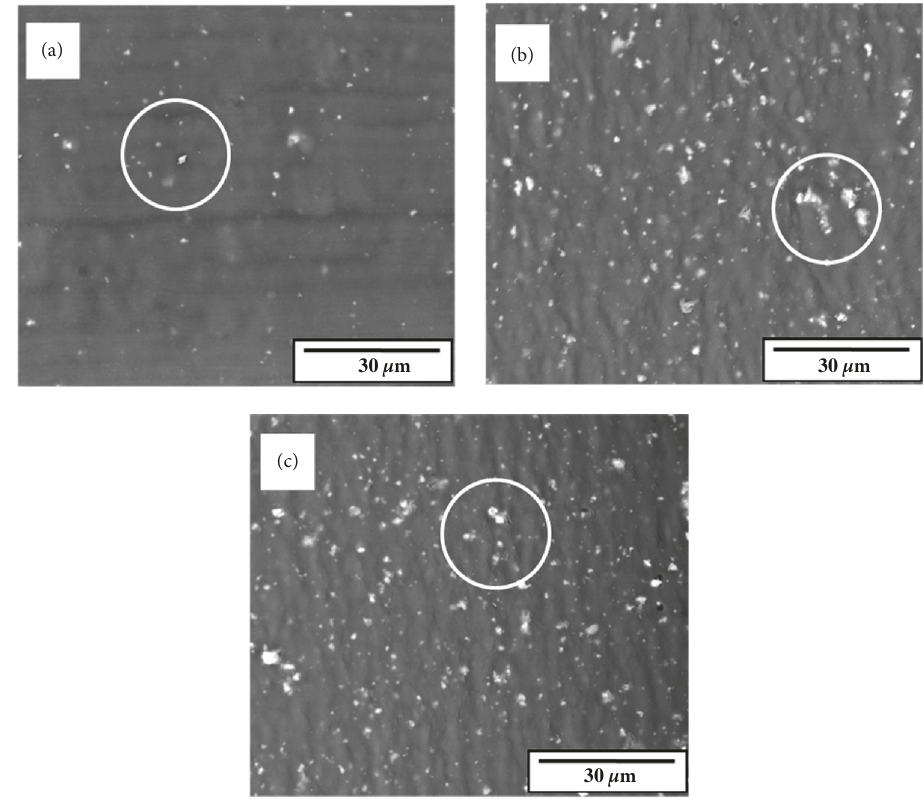
Figure 4: SEM images of scaffold surfaces: (a) PCL + 1 wt.% Biosilicate (cid:2) ; (b) PCL + 3wt.% Biosilicate (cid:2) ; (c) PCL + 5 wt.% Biosilicate (cid:2) . Circles indicate some agglomerates.